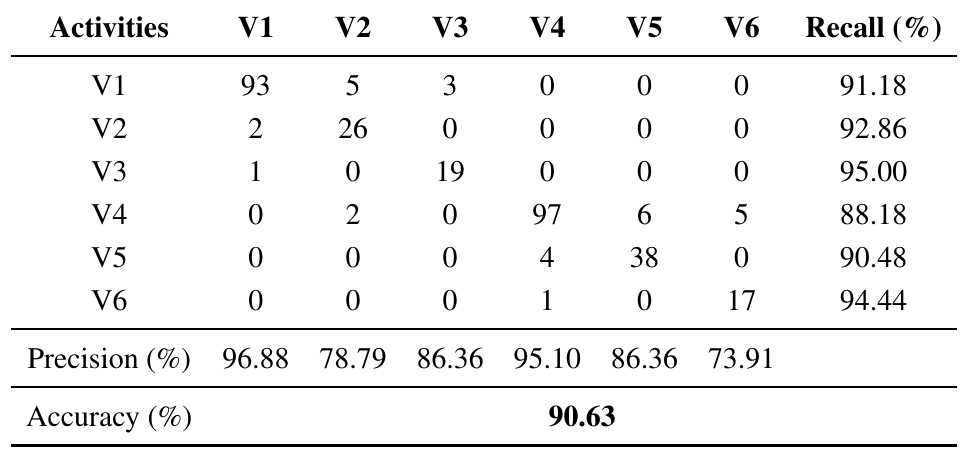
Table 3. Confusion matrix of the SVM classifier using PAM for the vertical traffic.